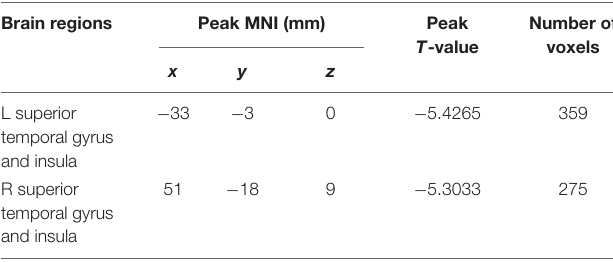
TABLE 4 | Significant difference between hemodialysis patients and healthy controls in functional connectivity between the bilateral thalamus (used as seed area) and the rest of the whole